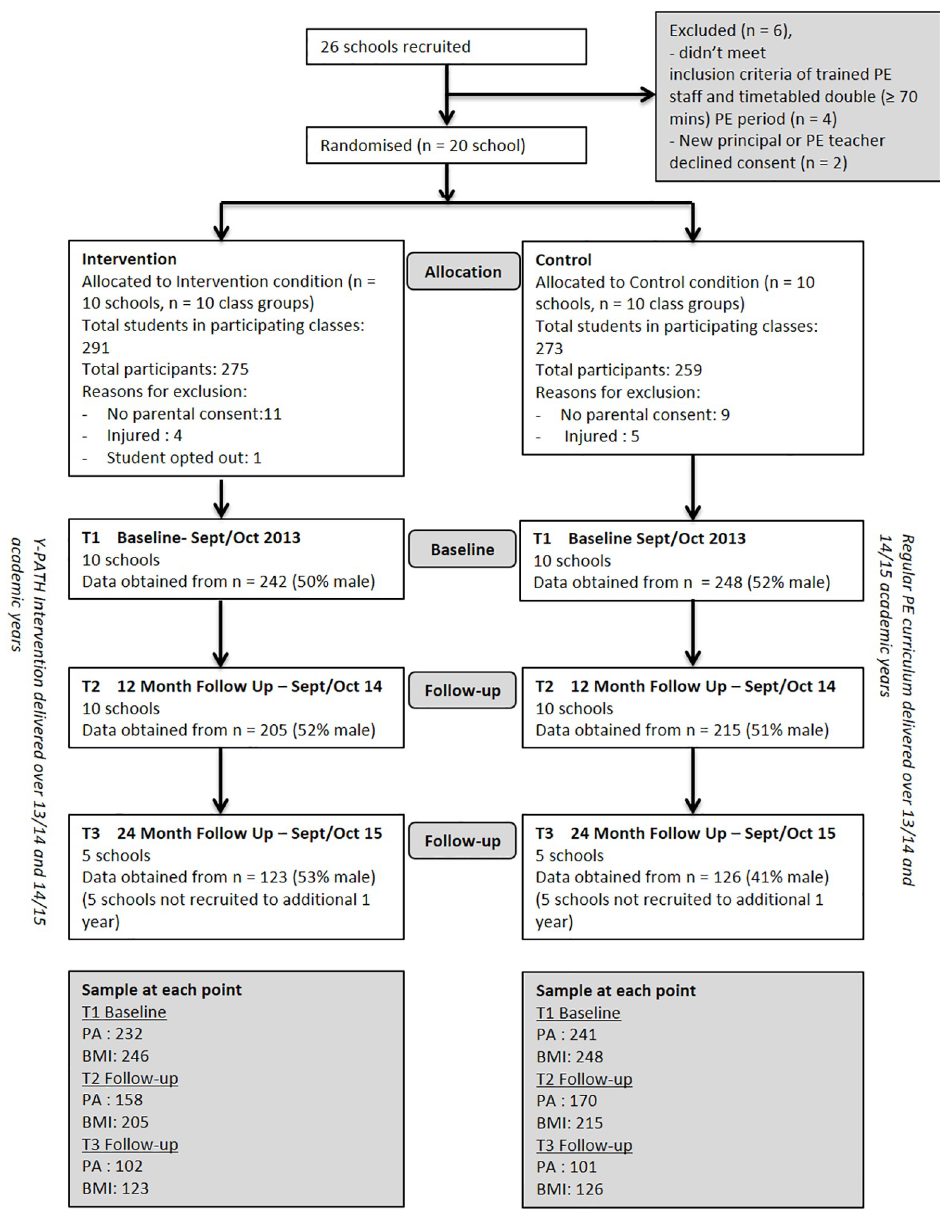
Fig 1. Flow of participants through the